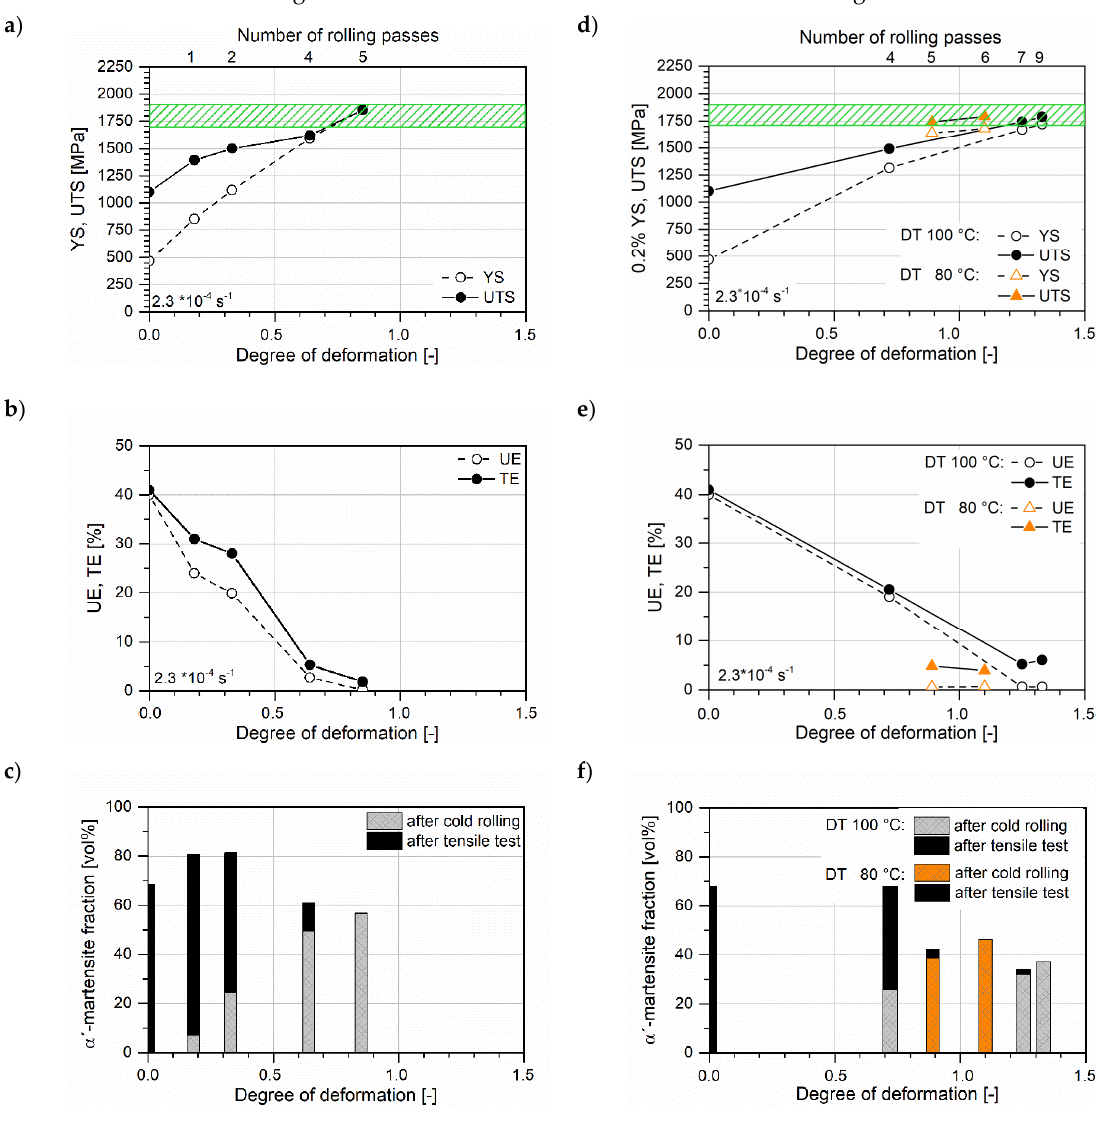
Figure 4. Mechanical properties and α ’ martensite fractions of cold-rolled steel strip as a function of the degree of deformation for rolling series 1 and 2; ( a , d ) YS and UTS, ( b , e ) UE and TE, and ( c , f ) α ’ martensite fraction in cold-rolled conditions and after tensile tests. The required tensile strength ranges for the spring steel strip + C1700 is marked with hatching.